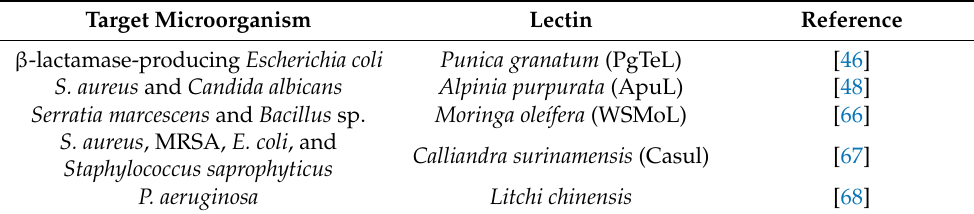
Table 3. Lectins with antibiofilm activity.